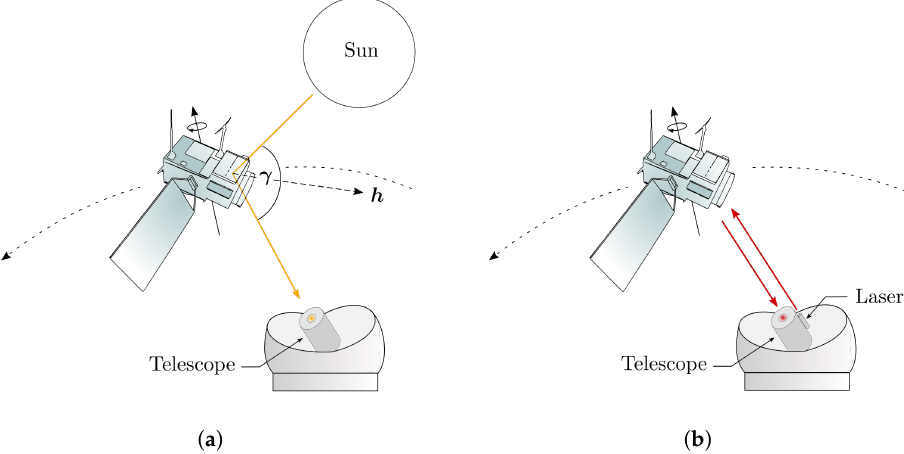
Figure 1. Space debris observations with phase vector h and phase angle γ . Illustration based on sketches of the TOPEX/Poseidon satellite model in [6]. ( a ) Passive sunlight observation (0 ◦ < γ ≤ 180 ◦ ). ( b ) Active laser observation ( γ = 0 ◦